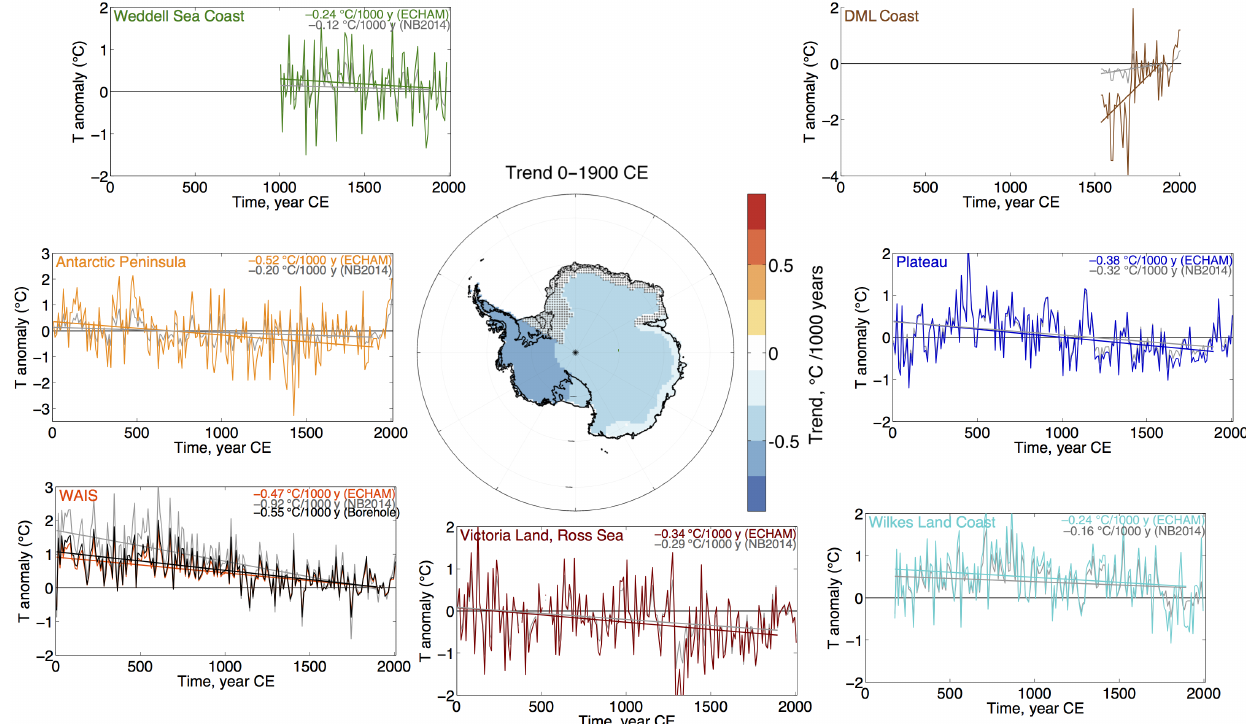
Figure 5. Regional temperature ( T anomalies in ◦ C, referenced to the 1900–1990CE period) reconstructions using 10-year data for the past 2000 years. Weighing method based on the correlation between site T and regional T from NB2014 forced by ERA-Interim. The temperature scaling method is (i) based on the correlation between annual mean regional δ 18 O and regional T from ECHAM5-wiso forced by ERA-Interim (coloured lines) and (ii) scaled on the NB2014 target over 1960–2010CE (grey lines), and the (iii) West Antarctic Ice Sheet region is adjusted to match the temperature trend between 1000 and 1600CE based on borehole temperature measurements (black line; Orsi et al., 2012). Linear trends are calculated over the period 0–1900CE using 10-year-binned data. The map at the centre reports the trend values calculated between 0 and 1900CE using 10-year data based on the ECHAM method adjusted to borehole data for the West Antarctic Ice Sheet region (the hatched area is not